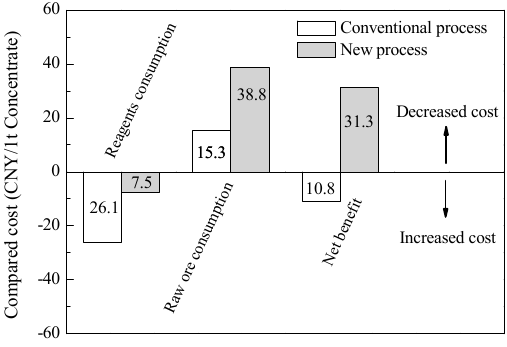
Figure 11. Benefit of the new process and the conventional process, compared to the actual process (2014).